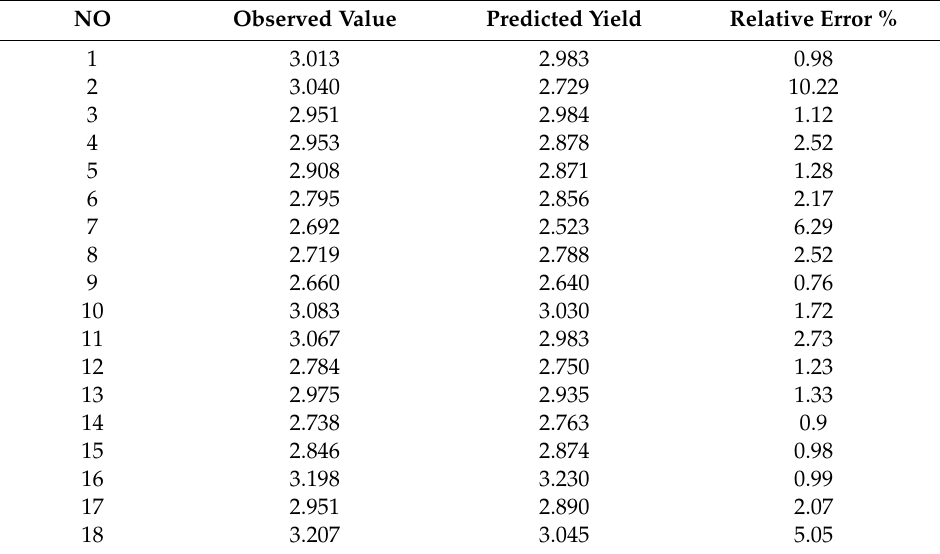
Table 4. Prediction results of BP neural network.